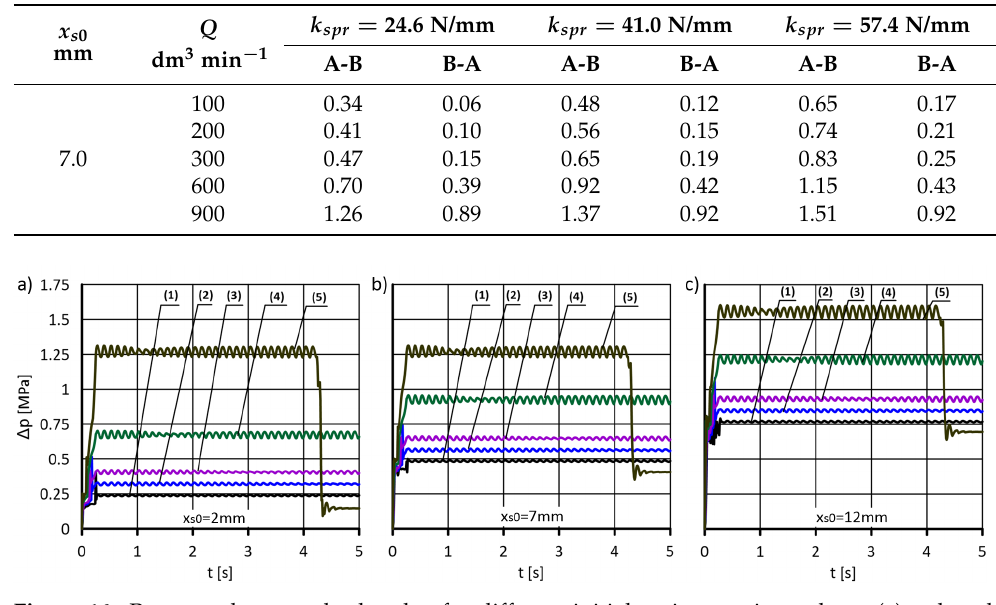
Figure 16. Pressure drop on check valve for different initial spring tension values: ( a ) reduced, ( b ) nominal, ( c ) increased; flow direction A-B.